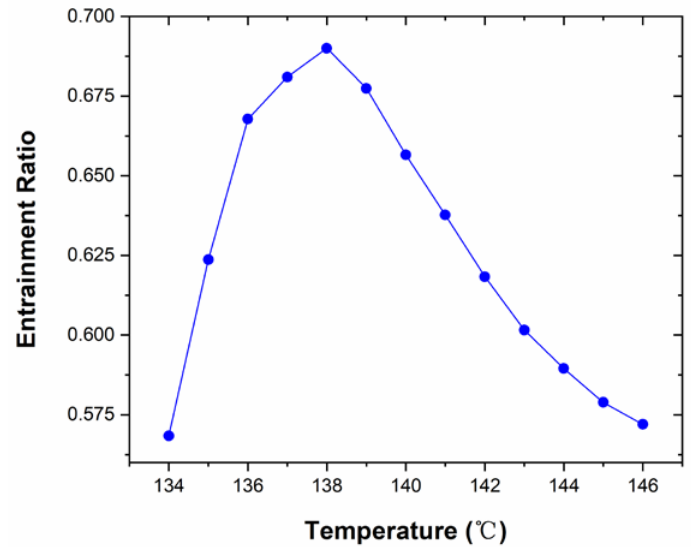
Figure 9. The variation of the entrainment ratio with the primary fluid pressure.